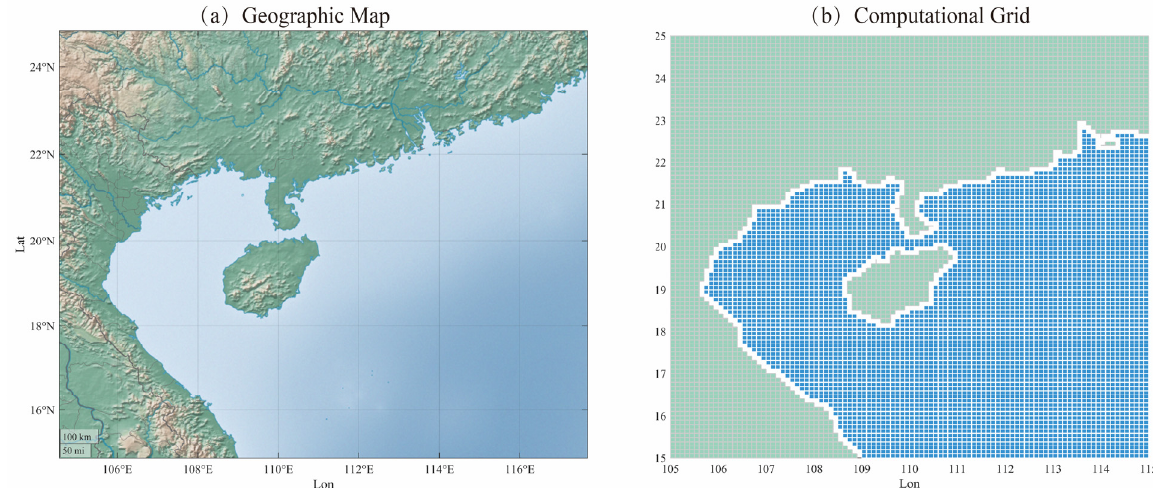
Figure 4. Discretization of geographic information.